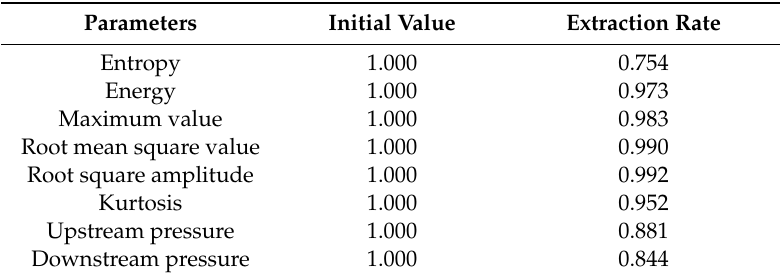
Table 2. Common factor variance.